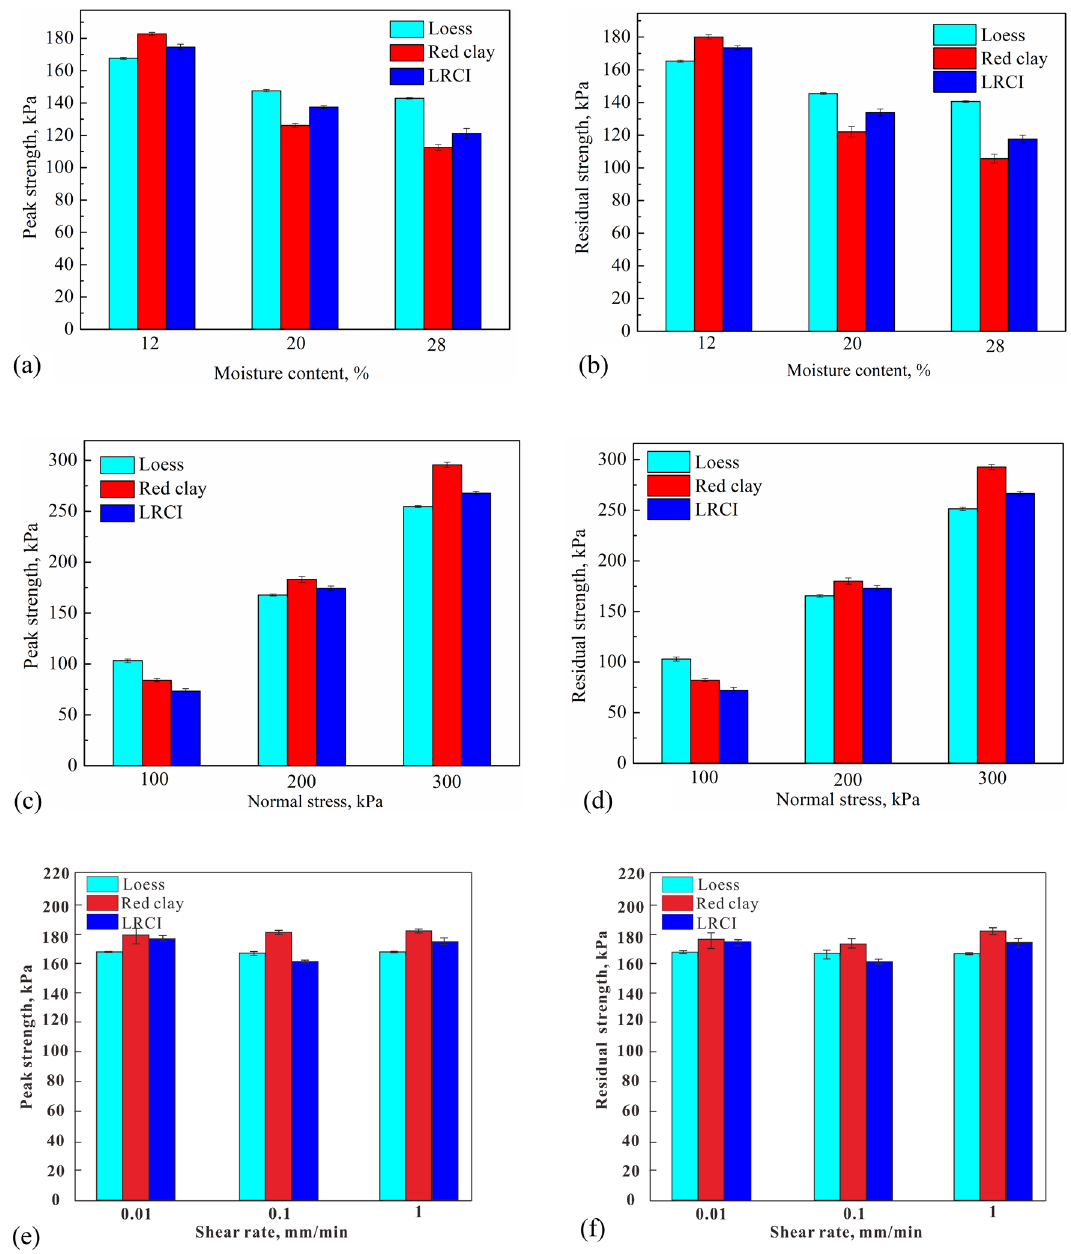
Figure 9. Histograms depicting peak strength and residual strength. ( a , b ) with moisture content; ( c , d ) with normal stress; ( e , f ) with shear rate. Error bars represent standard error (n =